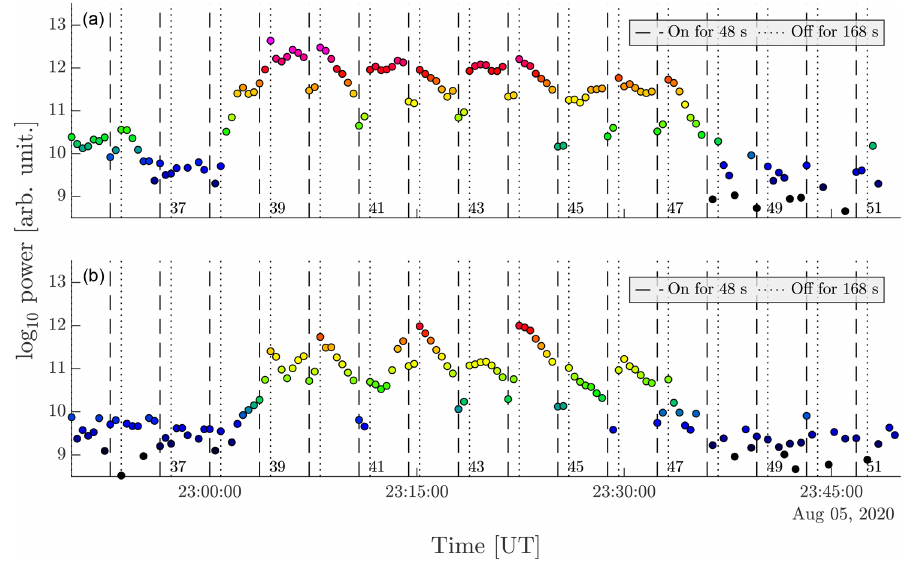
Figure 6. Backscattered power at altitude 85.2km (b) and 85.6km (a) and heating intervals observed during the night of 5/6 August 2020 in area 2. The color of the dots follows the color scale of Fig.